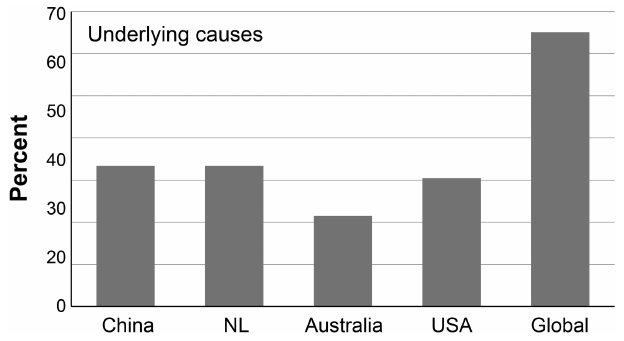
Fig. 5 . The relative importance of self-reliance in disaster resilience interpretations. This graph shows the percentage